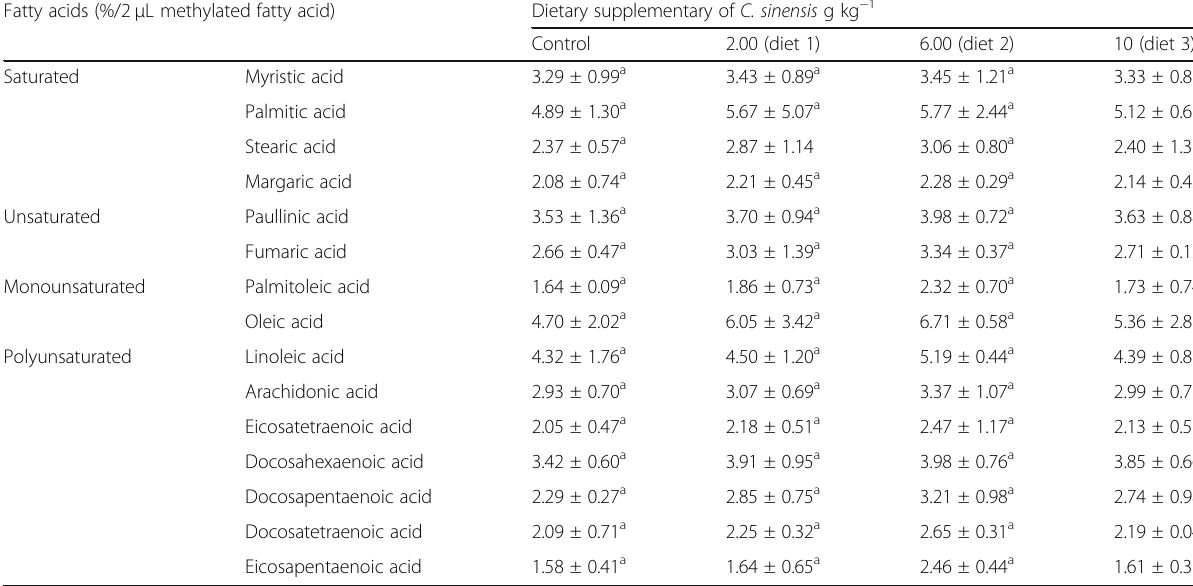
Table 6 Fatty acid profile of Catla catla fed with C. sinensis -supplemented diets Fatty acids (%/2 μ L methylated fatty